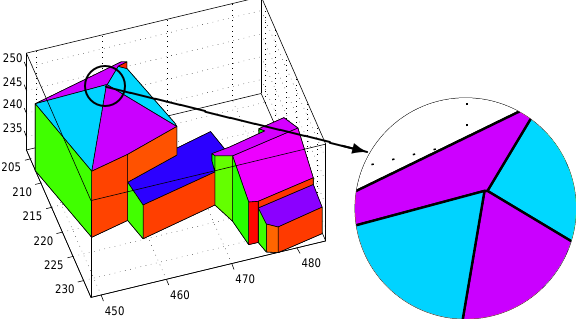
Figure 1: The pyramidal broach roof has been reconstructed as a hipped roof with a very short ridge line. The adjustment pro- cess enforces the concurrence constraint and therefore changes the topology of the roof to a pyramidal